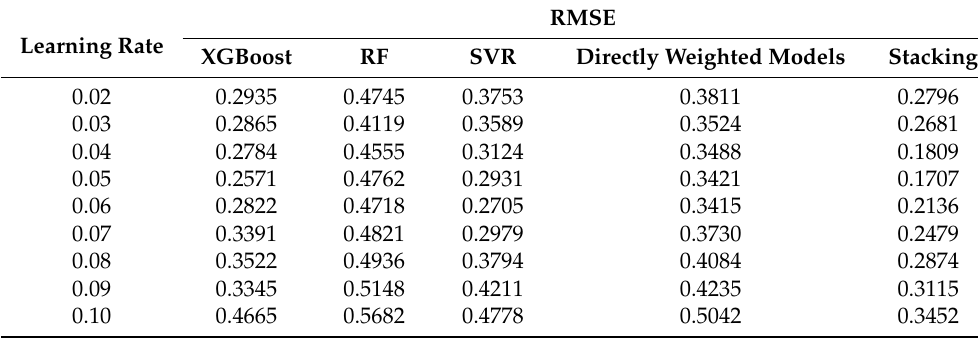
Table 4. Root-mean-square error of each model under different learning rates.